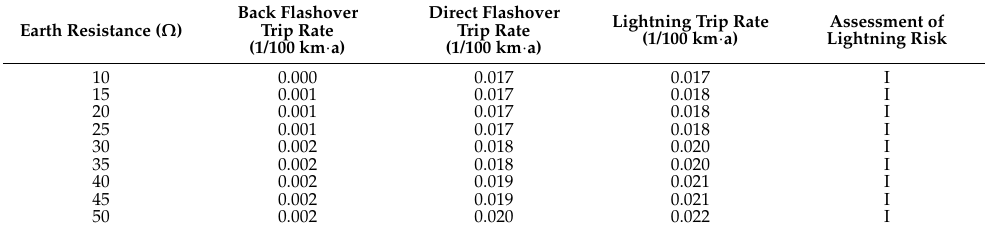
Table 1. Lightning trip rate of the line no ground wire under the earth resistance changes.